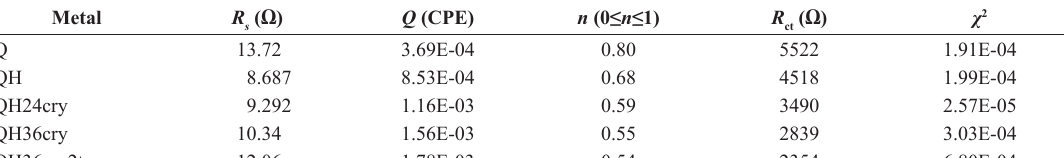
Table 3. Impedance parameters for different pre-treated AISI D3 steel samples in 3.5% NaCl solution